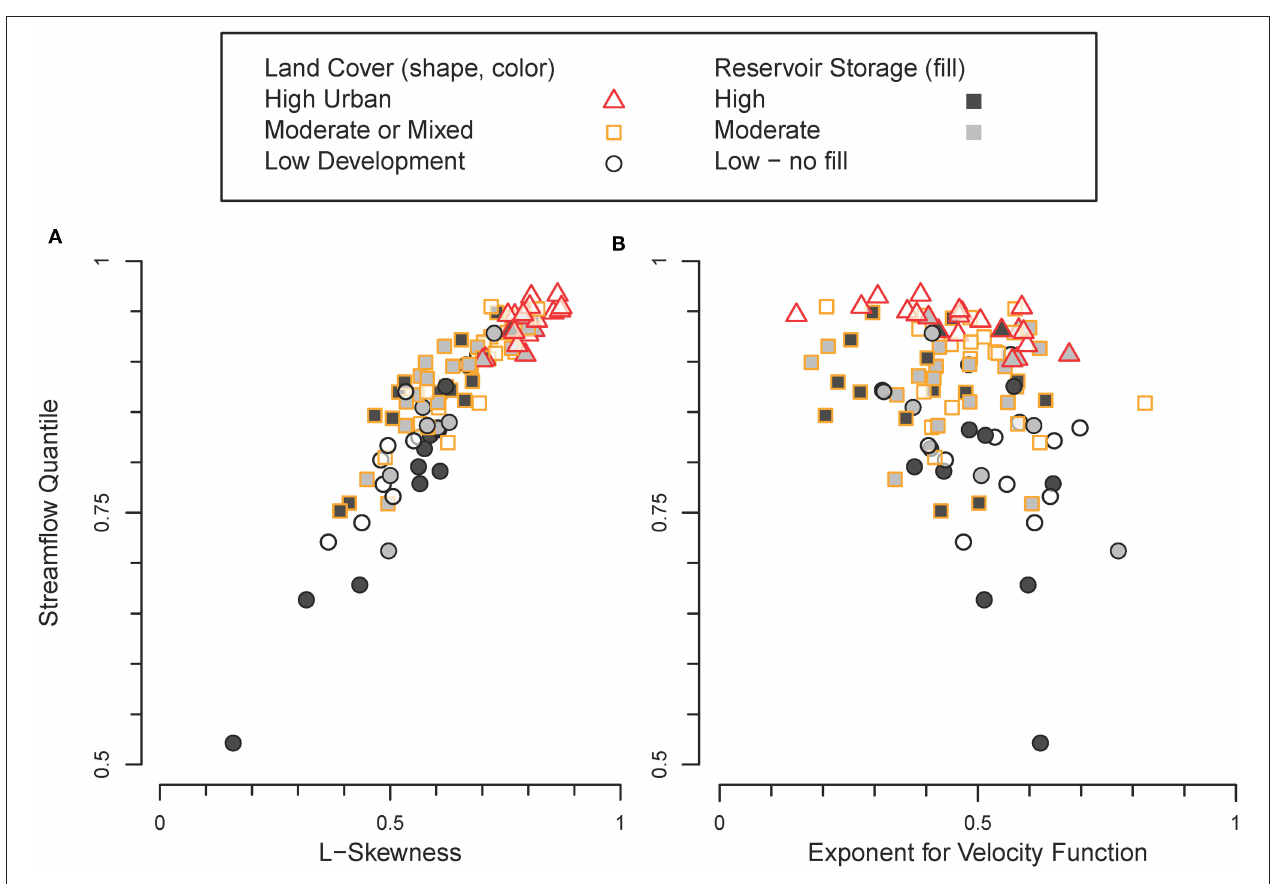
FIGURE 4 | The streamflow quantile with a specific travel time equal to the effective travel time in relation to (A) linear (L-) skewness of the streamflow distribution and (B) the exponent for the velocity-discharge function (Equation 5).